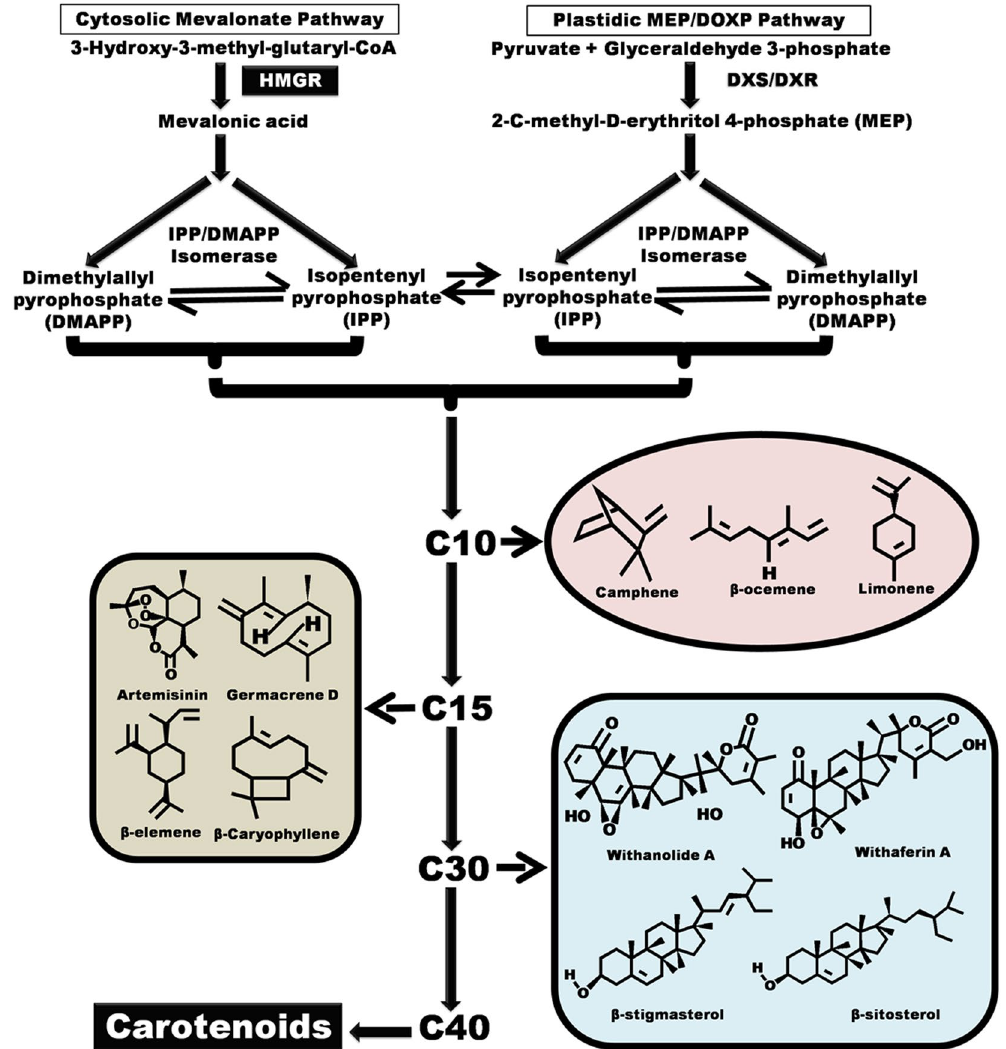
Figure 1. Schematic diagram of terpenoid biosynthetic pathway through mevalonate (MVA) as well as methyl- erythritol-phosphate (MEP)